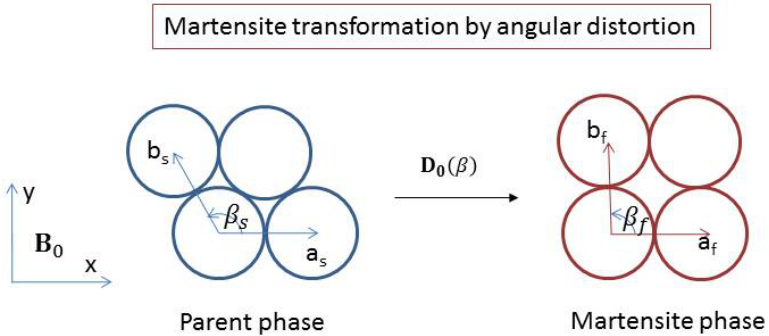
Figure 17. Hexagonal–square transformation with angular distortion.